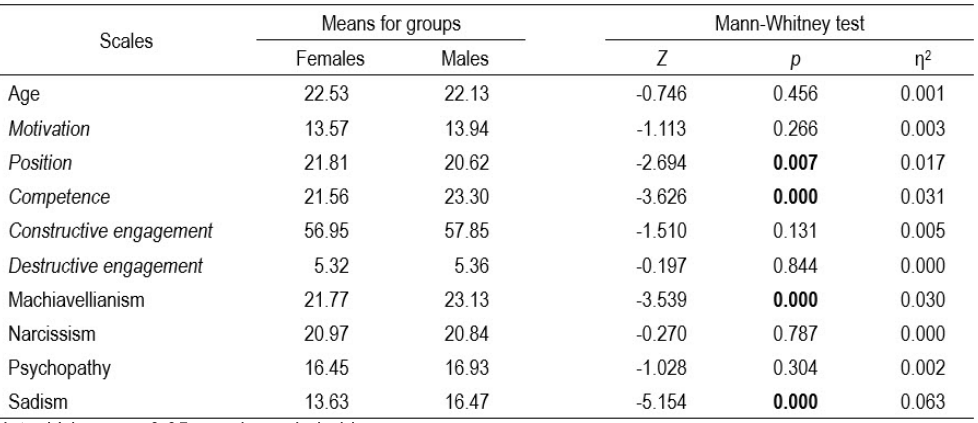
Comparison of means for groups of females (n=275) and males